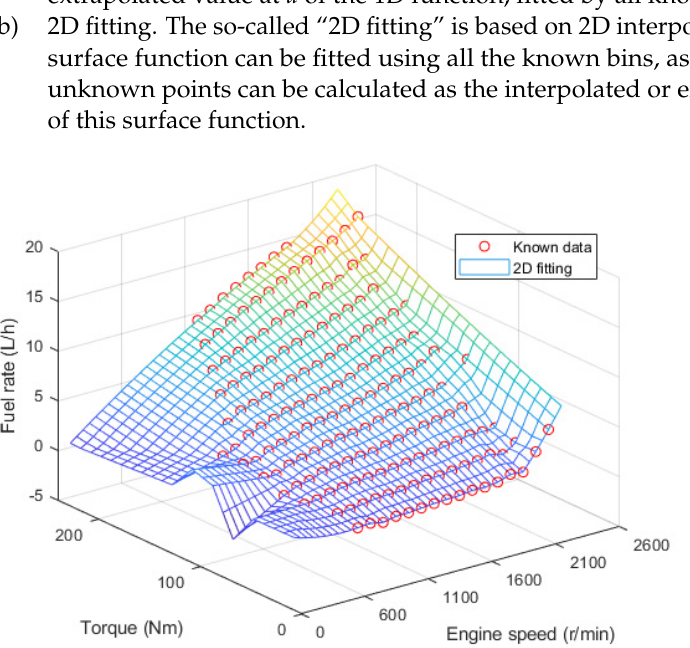
Figure 6. Two-dimensional fitting to predict unknown data (vehicle one, n100T25).